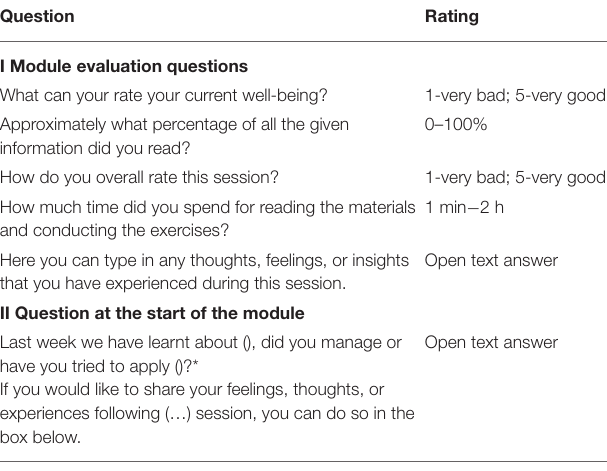
TABLE 1 | List of module evaluation questions for the pilot RCT